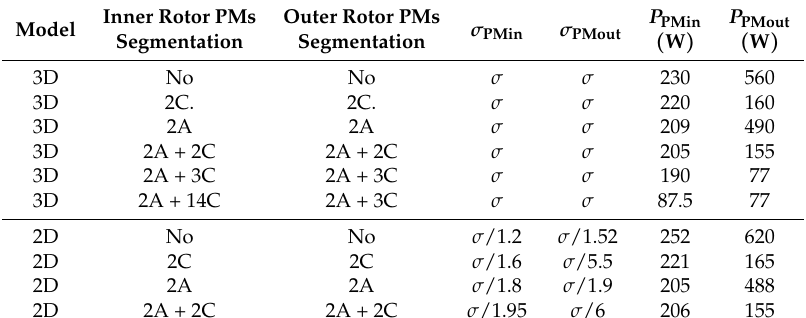
Table 2. Comparison of the permanent magnets (PMs) losses at ω in = 5000 rpm with no segmentation and with circumferential (C) or axial (A) segmentation.